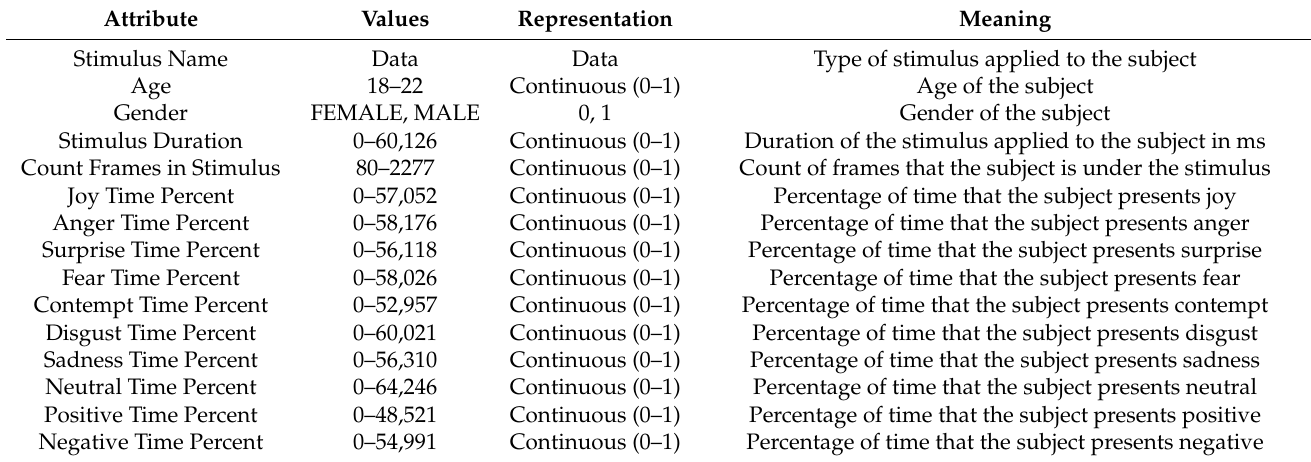
Table A2. Dataset register attributes.